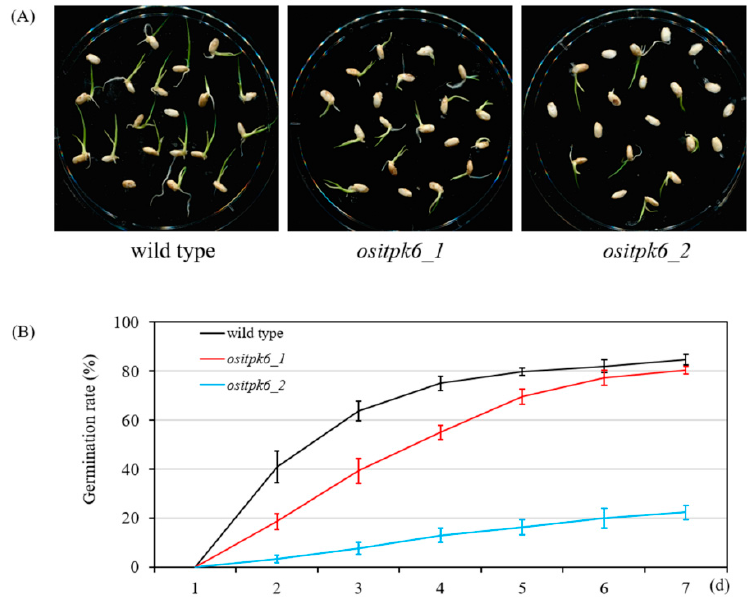
Figure 3. Germination rate of mutant seeds. ( A ) The pictures were taken on the 5th day after soaking. ( B ) The germination rate was recorded from 1 to 7 days after soaking, and three replicates were examined in each group.